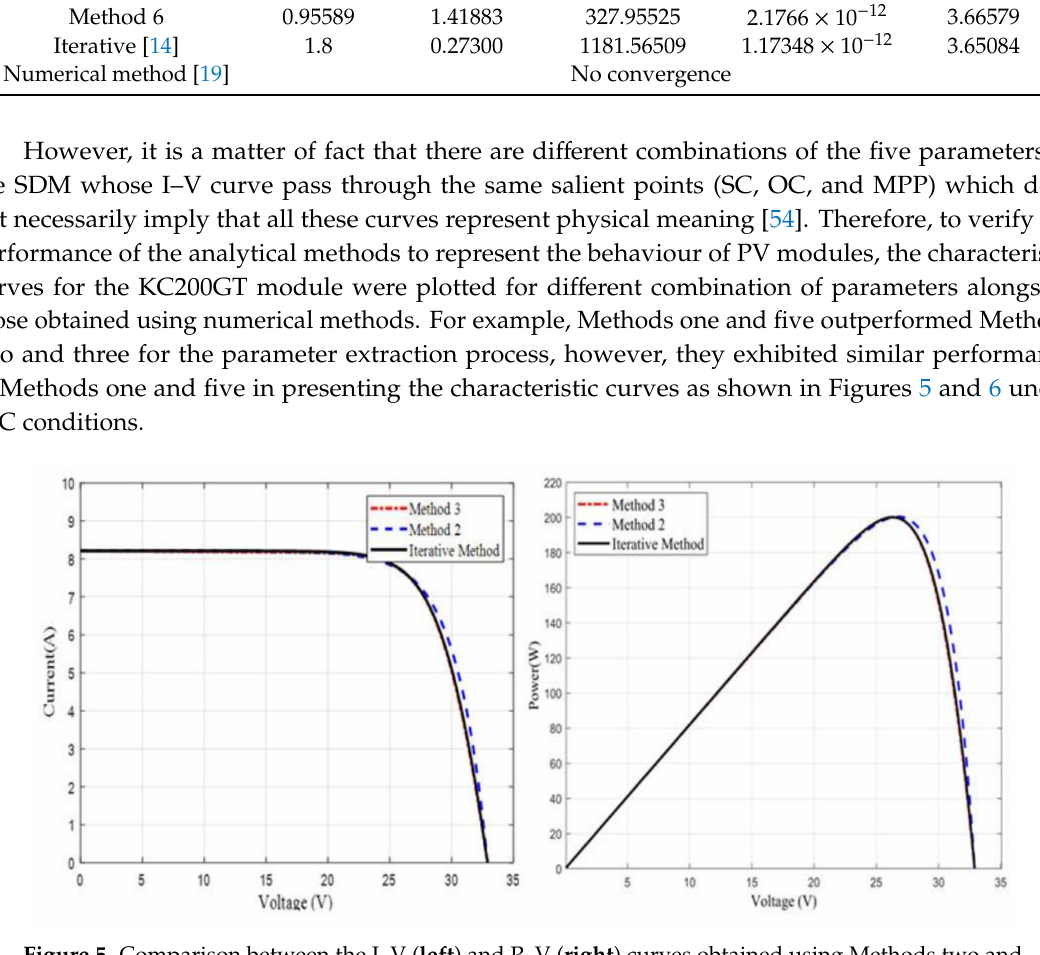
Figure 5. Comparison between the I–V ( left ) and P–V ( right ) curves obtained using Methods two and three with those obtained using numerical method for the KC200GT